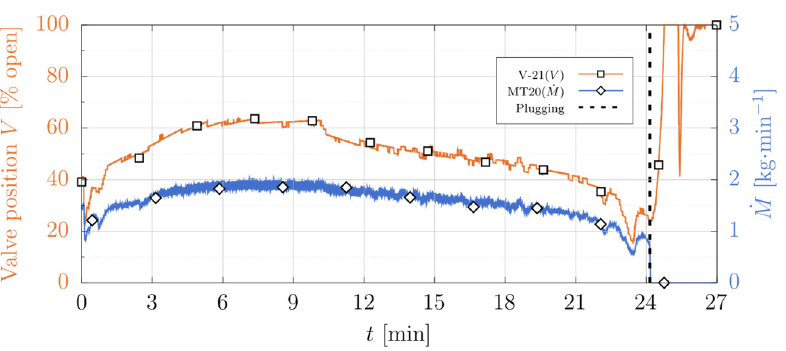
Figure 7. Pressure and liquid temperature in the second separator (SV02) during Experiment 3. The first vertical line shows the onset of freeze out, and the second marks the point of plugging.